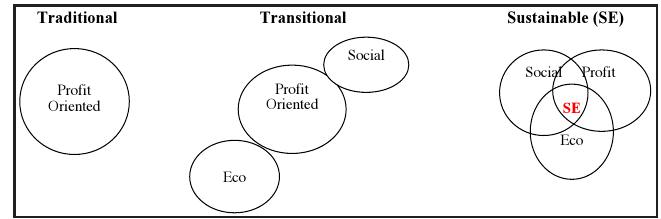
Figure 1: The Evolution of